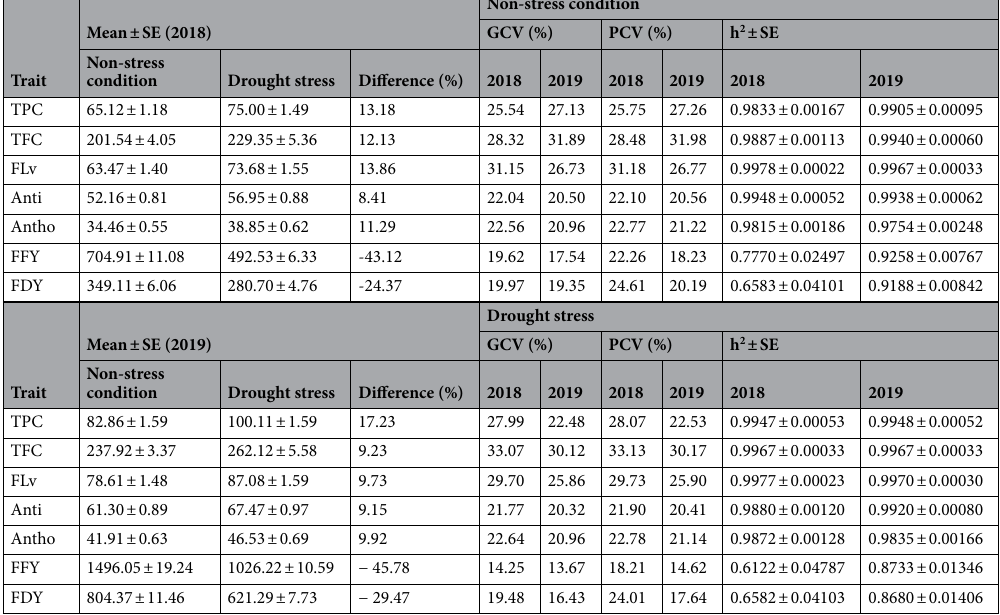
Table 4. Mean values, genotypic coefficients of variation (GCV), phenotypic coefficients of variation (PCV) and broad-sense heritability (h 2 ) of studied traits measured from one-hundred accessions of Poa pratensis evaluated in non-stress and drought stress environments during years 2018 and 2019. TPC, total phenol content; TFC, total flavonoid content; FLv, flavanone; Anti, antioxidant activity; Antho, anthocyanin; FFY, forage fresh yield; FDY, forage dry weight; SE, standard error of the